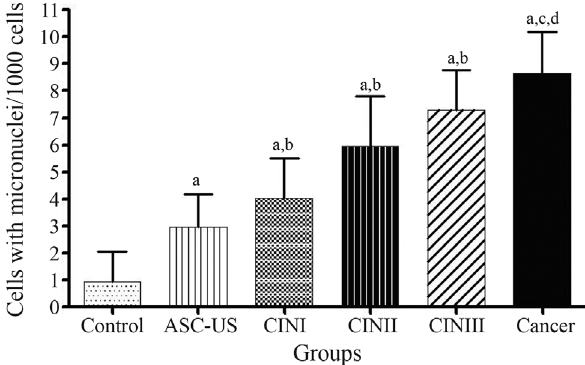
Figure 2 - Frequency of micronuclei in each of the groups evaluated. a,b,c,d Significant compared to the control (p < 0.001), ASC-US (p < 0.01), ASC-US(p<0.001)andCINI(p<0.01)groups,respectively.Inallcases, thesignificancewasdeterminedusingtheKruskall-Wallistest.ASC-US– atypical squamous cells of undetermined significance, CIN – cervical intraepithelial neoplasia (grades I, II and III), and IC – invasive cancer. The columns are the mean (cid:2) SD of total individual analyzed per